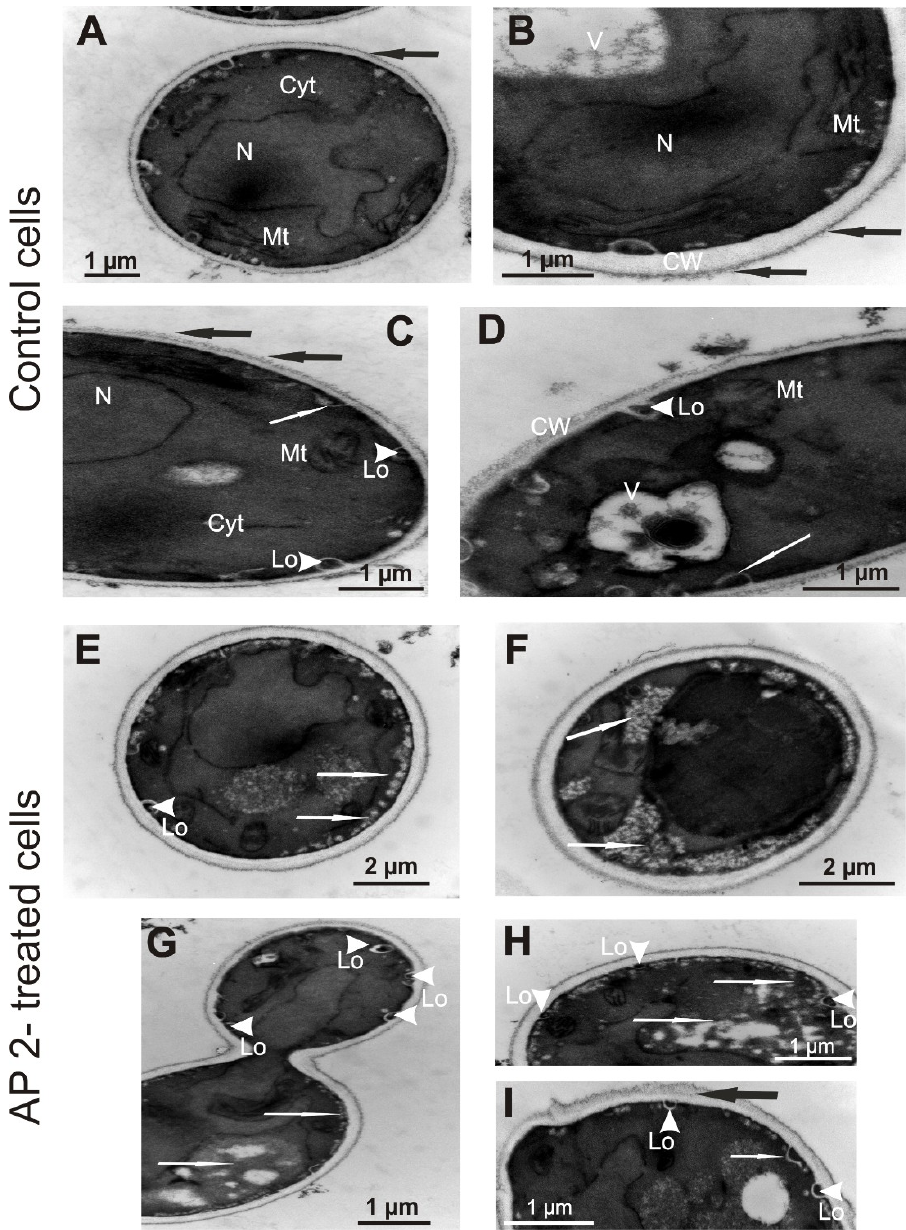
Figure 4. TEM images of C. albicans cells treated with AP2 for 1 h. The log-phase cells were incubated without (control; A – D ) or with 5 μM AP2 ( E – I ) at 37 °C for 1 h. Then, the cells were imaged by TEM. A —control cell with well discernible cytoplasm (Cyt), nucleus (N), mitochondria (Mt), cell wall, and membrane. Note the presence of short, evenly distributed fibrils (black arrow) attached to the cell wall. B —enlargement of a fragment of the cell presenting cell wall (CW) with fibrils (black arrows), big vacuole (V), nucleus (N). C , D —fragments of the cells from the control culture with well visible fibrils (black arrows), big vacuoles (V), and other organelles. Cell membrane invaginations (white arrows) and lomasomes (Lo, white arrowheads) are visible. E , F —cells from the culture incubated with AP2 in which the presence of many small vacuoles located in the peripheral part of the cell or inside the cell are visible (white arrows). G , H —cells with noticeable vacuolated regions in the cytoplasm, tiny vacuoles close to cell membrane (white arrows), and lomasomes (Lo, white arrowheads). I —cell with cell membrane invagination (white arrow), lomasomes (Lo, white arrowheads), and some portion of the cell wall with distorted structure (black arrow).